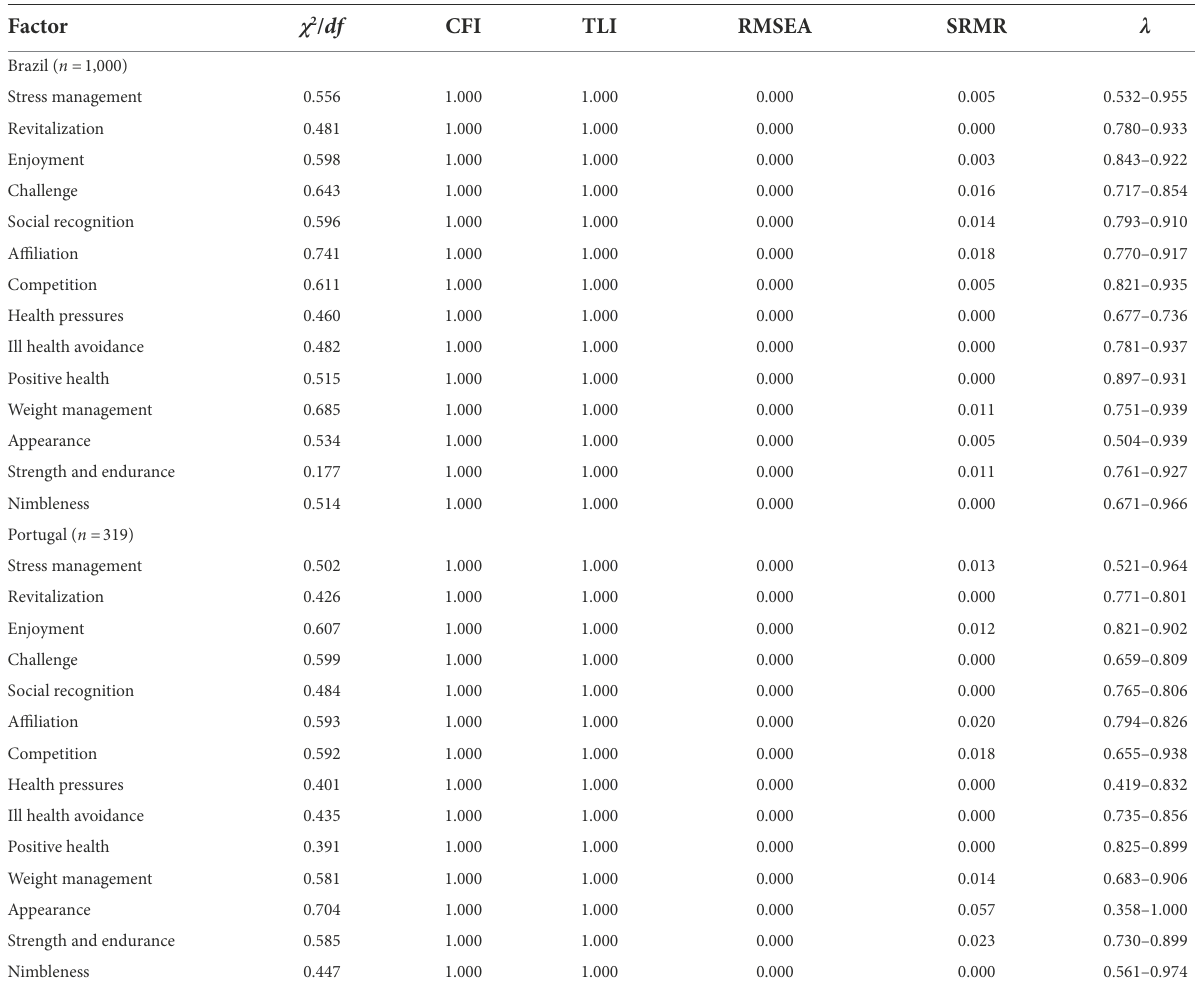
TABLE 2 Fit of the 14 factors of the exercise motivations inventory (EMI-2) as single-factor models to the samples from Brazil and